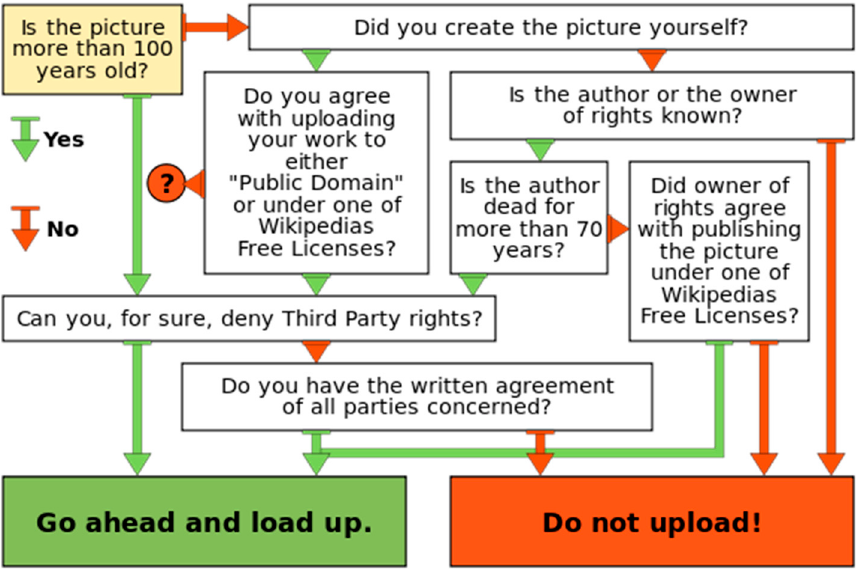
Figure 1. Decision tree illustration by Stefan Lew (Public Domain).